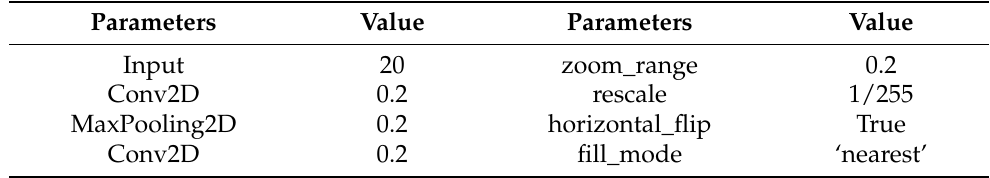
Table 5. Augmentation parameters and their